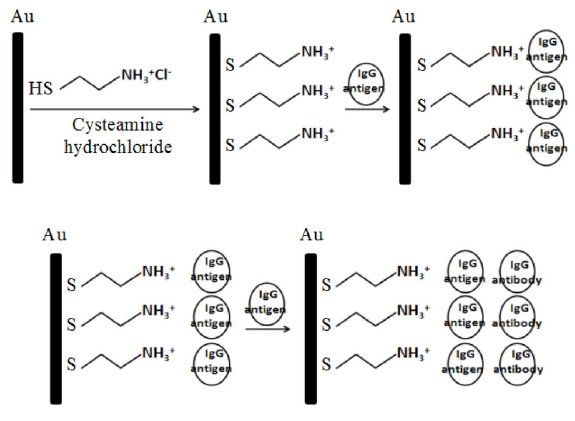
Fig. 2 Protein detection flow chart of the TFBG -SPR protein molecular probe.